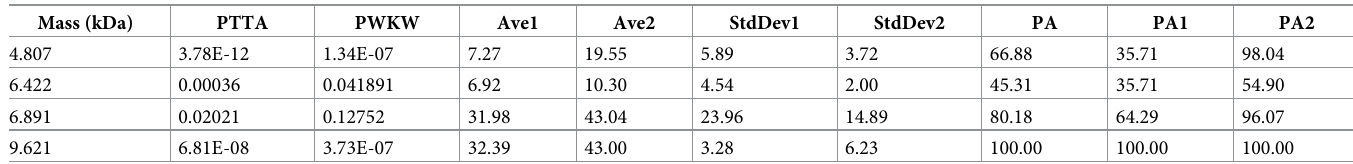
Table 1. Statistical evaluation of the 4 peaks with an overall frequency of appearance higher than 30% based on the multidrug resistant vs susceptible data set. Mass